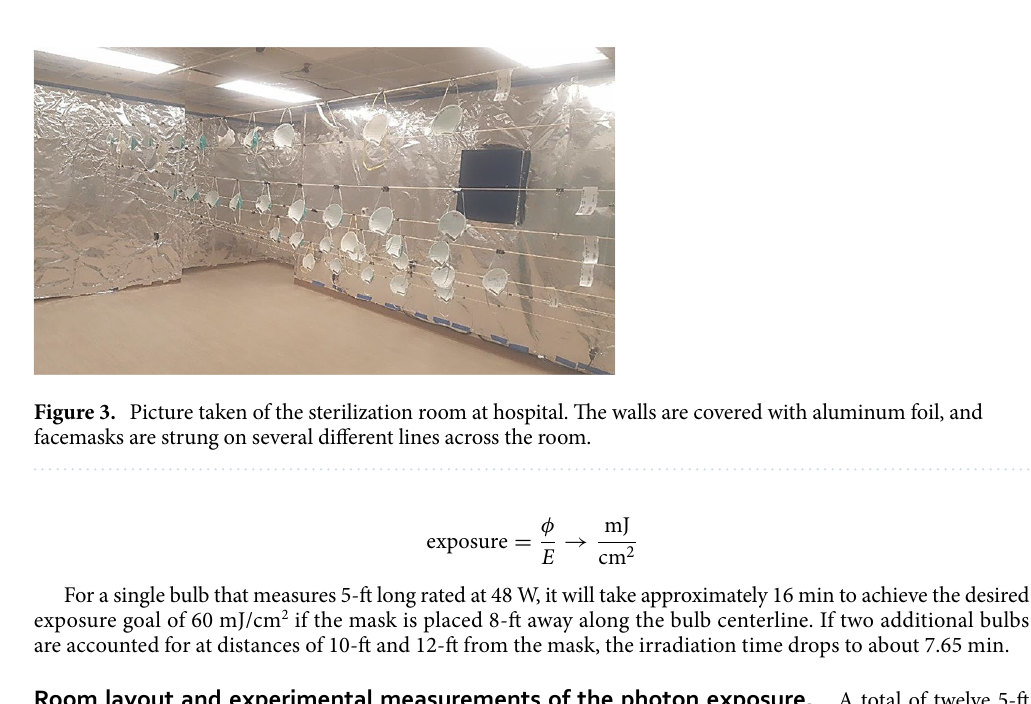
Figure 2. A top-down (left) and isometric (right) view of the UV sterilization room with bulb placements.